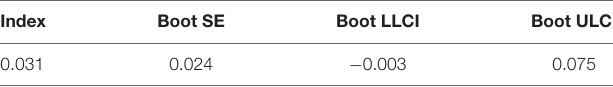
TABLE 10 | Index of moderated mediation analysis.